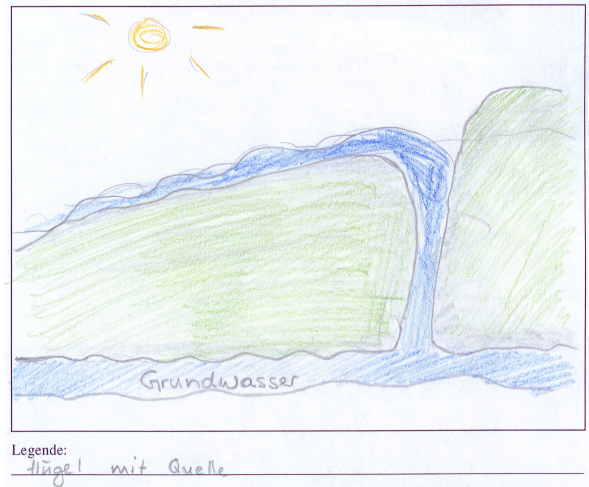
Fig. 2. Drawing of student 031F (girl, 13yr old). Label in the draw- ing=ground water; legend=hill with a